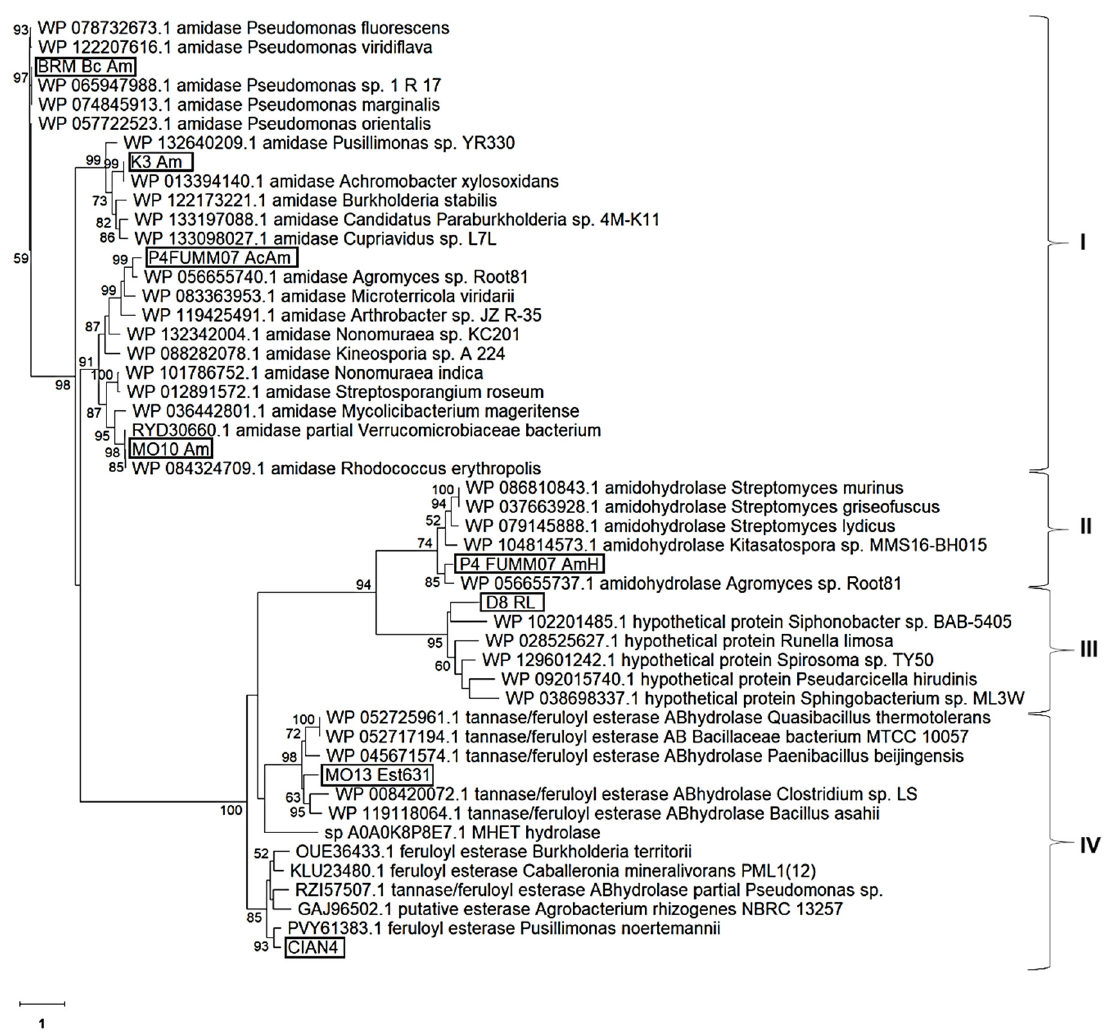
Figure 2. Phylogenetic tree of the selected amidases. The NCBI Database attributes the 8 selected hydrolases to 4 different superfamilies: I —amidase signature (AS) enzymes (SSF75304), II —metal- dependent amidohydrolases (SSF51338; SSF51556), III —uncharacterized, activating signal